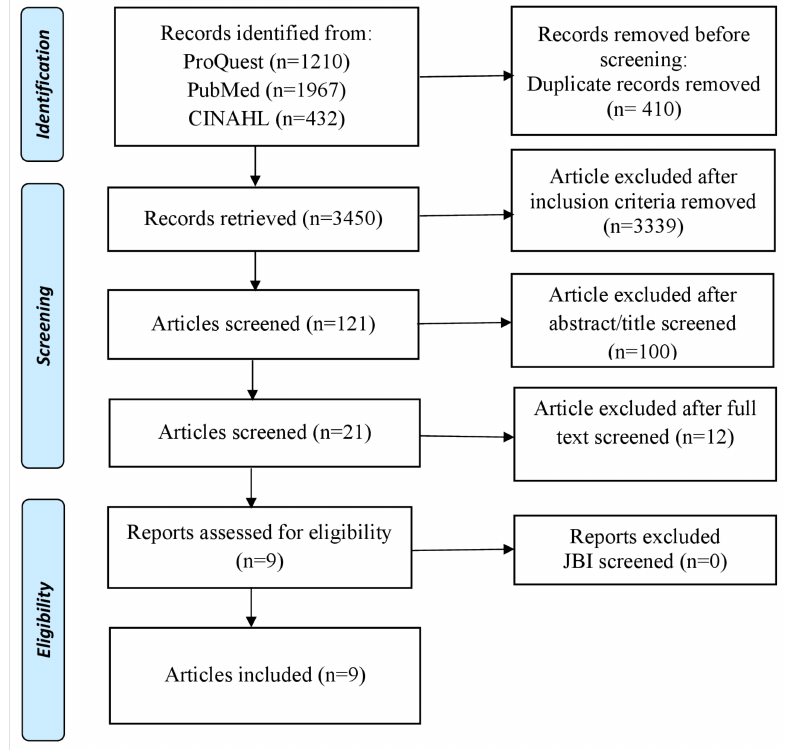
Figure 1. PRISMA Flow